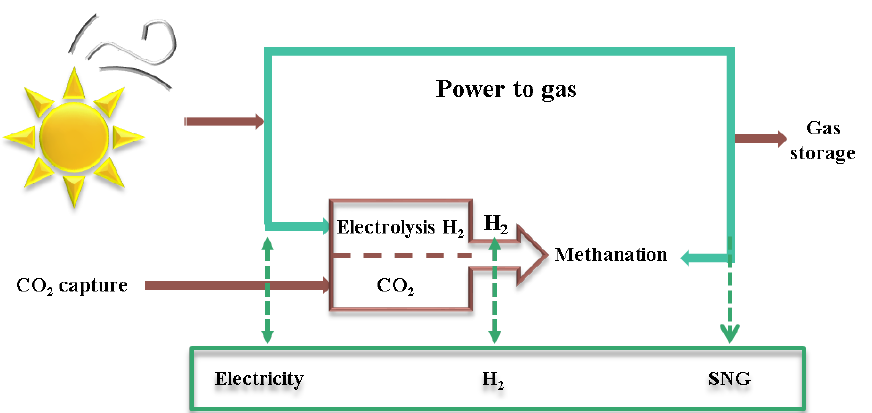
Figure 14. Chemical compounds and fuels produced sustainably using CO 2 . At various temperatures, the equilibrium conversion of CO 2 to methane is plotted from the previous literature data.